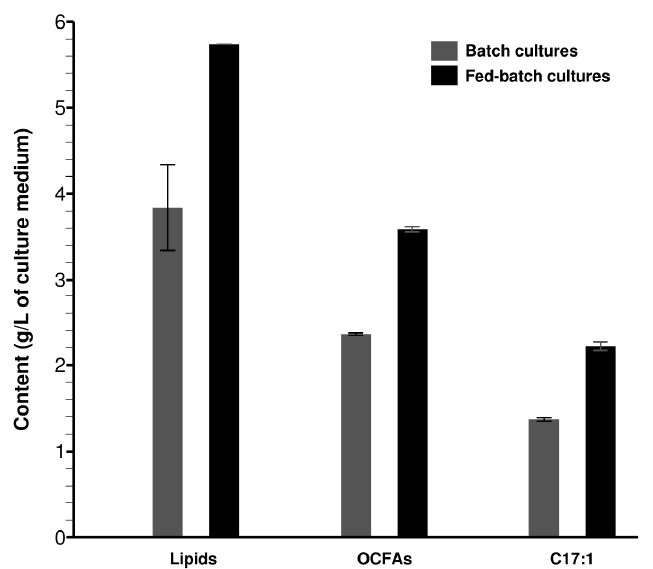
Figure 5. Lipids, OCFAs and C17:1 contents obtained after 160 h of fermentation by Y. lipolytica in 5-L bioreactors (batch and fed batch cultures).